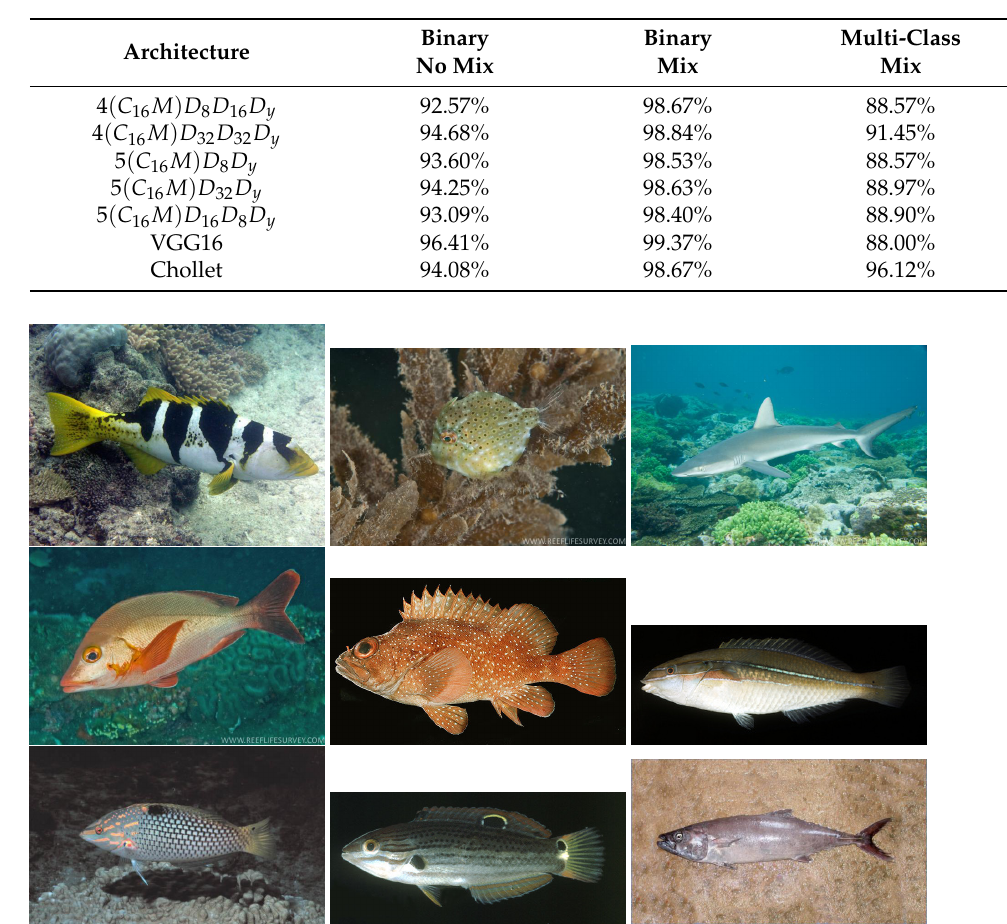
Table 8. Accuracy of the additional experiments: Binary–No mix is a binary classification experiment using the dataset QUT+NOA versus the Symbiosis-NCC dataset of Table 5, with the split of Table 6. Binary–Mix is a binary classification experiment using the dataset QUT+NOA versus the Symbiosis- NCC dataset of Table 5, with a (80%, 10%, 10%) split. Multi-class–Mix is a multiclass classification